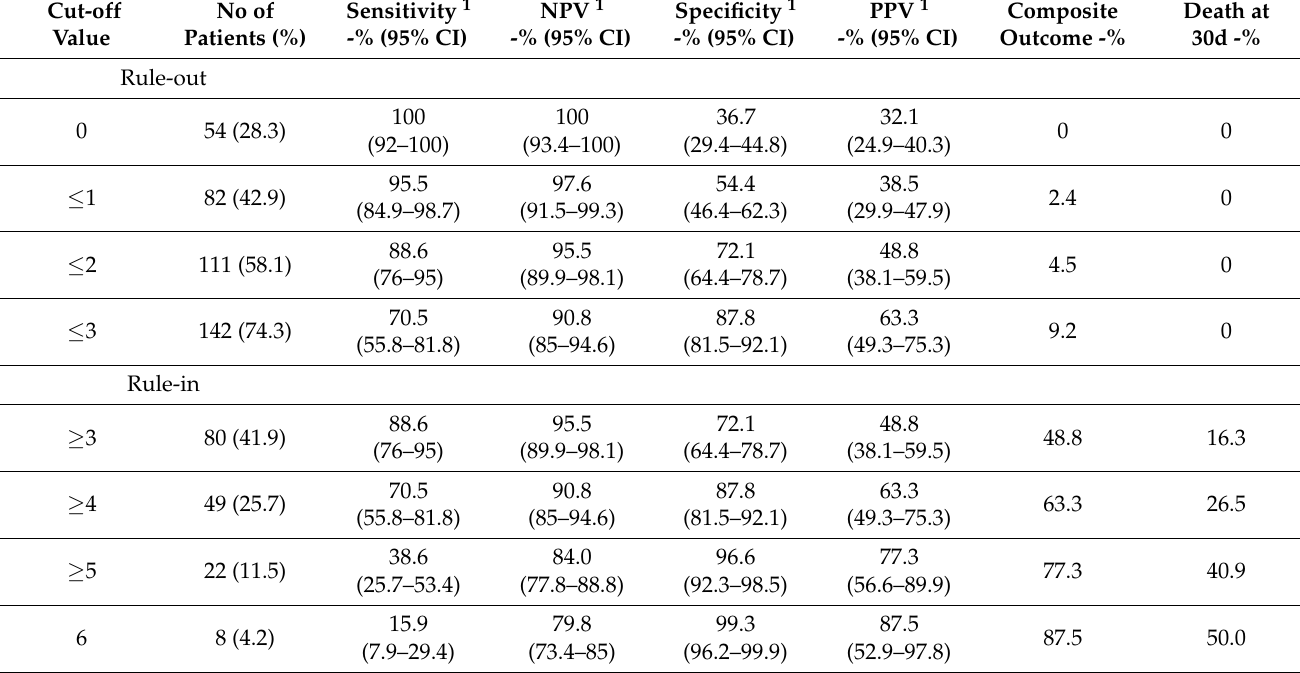
Table 6. Performance metrics of the COLT-58-Score to rule out and rule in endpoints at different cut-off values in COVID-19.